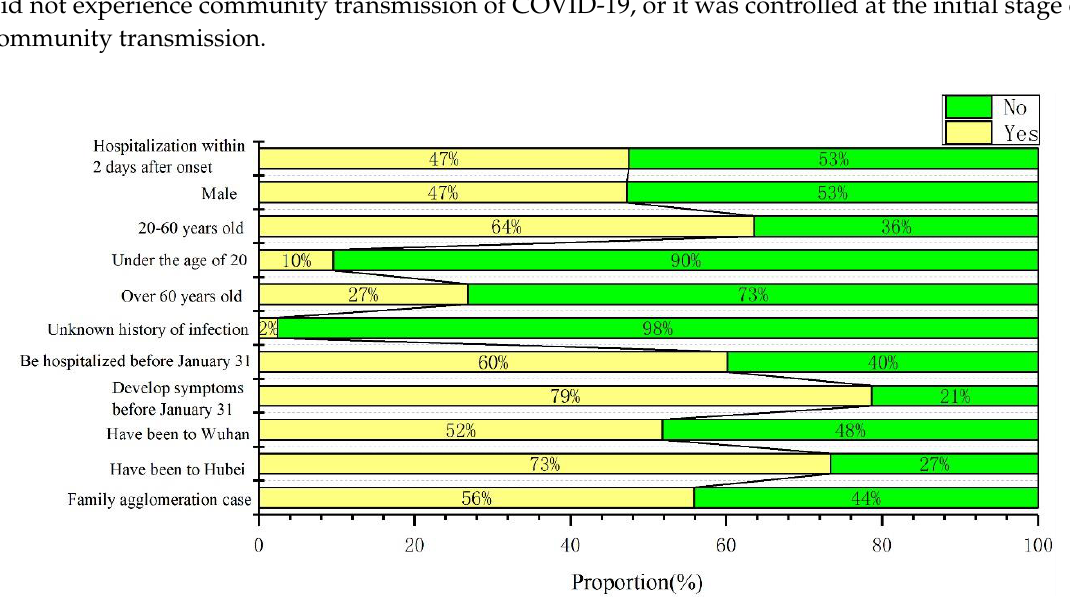
Figure 2. Case structure of COVID-19 in Shenzhen, China.